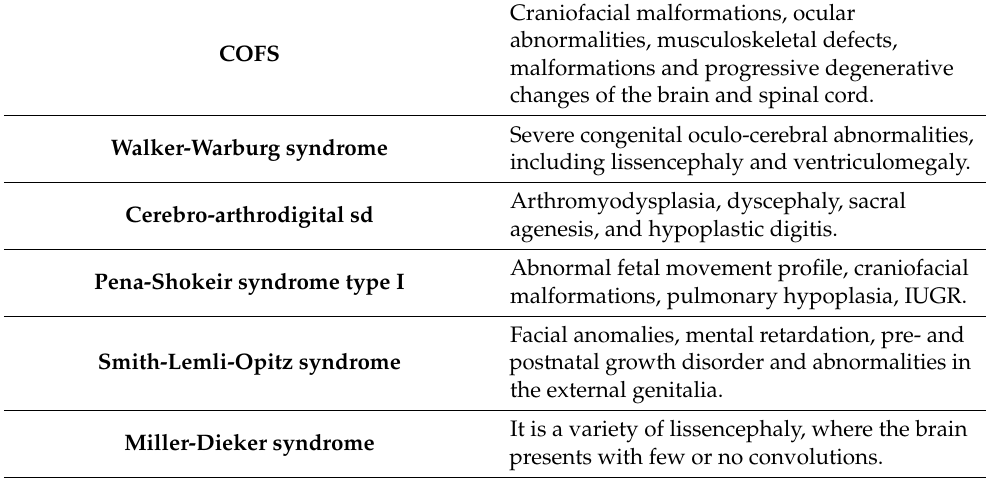
Table 2. Differential diagnosis of the NLS [3]. Craniofacial malformations, ocular abnormalities, musculoskeletal defects, COFS malformations and progressive degenerative changes of the brain and spinal